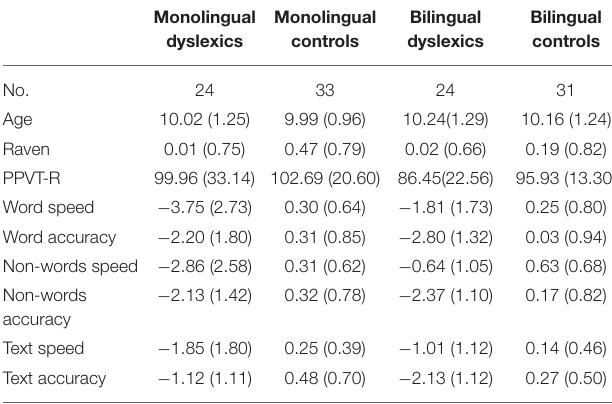
TABLE 4 | Number, mean (SD) age in years, means (SDs) of z scores on the Raven and the reading tasks, and mean (SDs) of raw scores of the